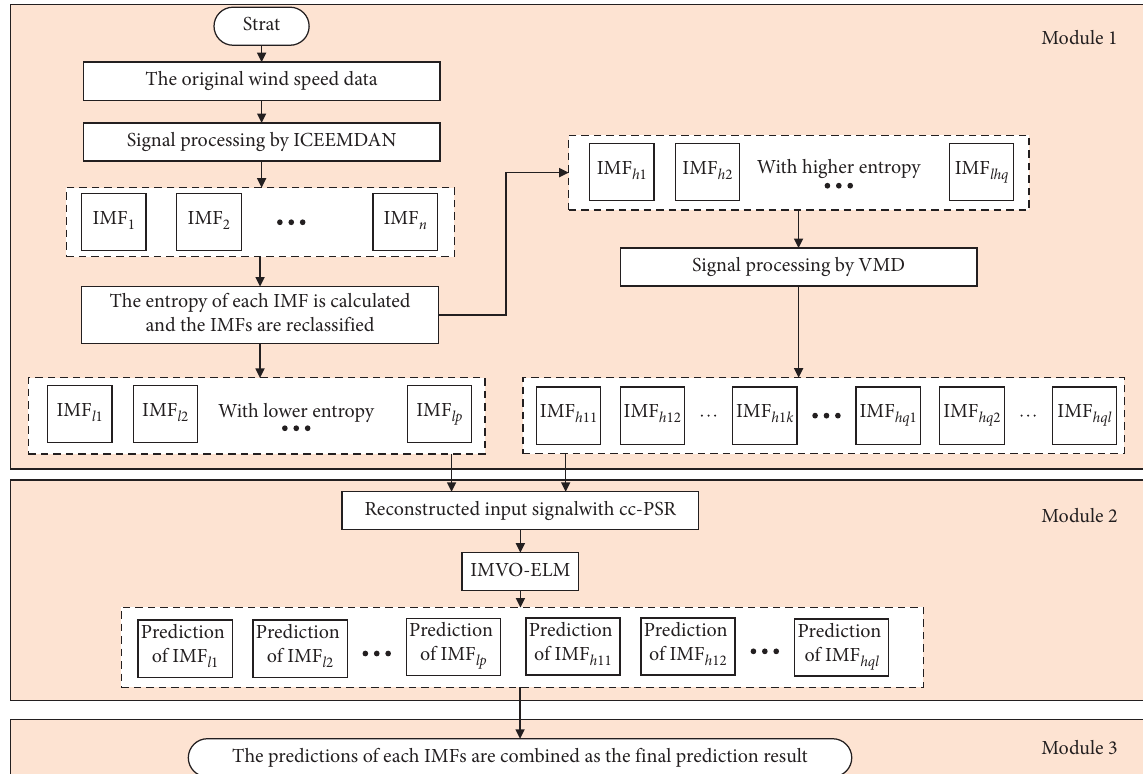
Figure 1: The structure of the proposed hybrid